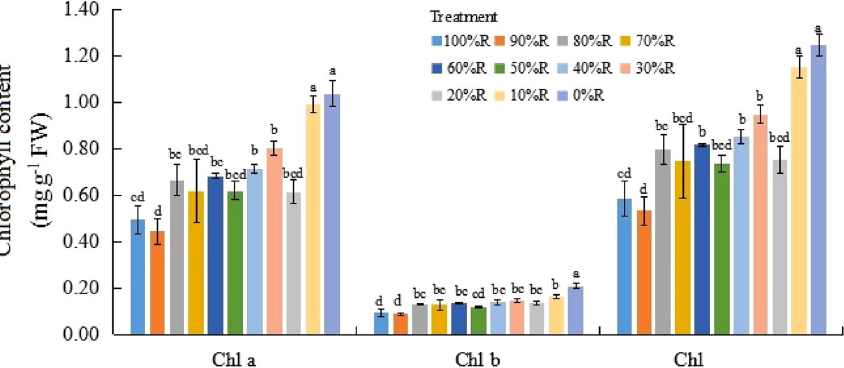
Figure 4. Chlorophyll (Chl) contents of plants grown under different light treatments (at harvest). Different letters for the same parameter indicate significant differences at the 5% level, according to the Tukey’s test (n = 3). The bars represent the standard